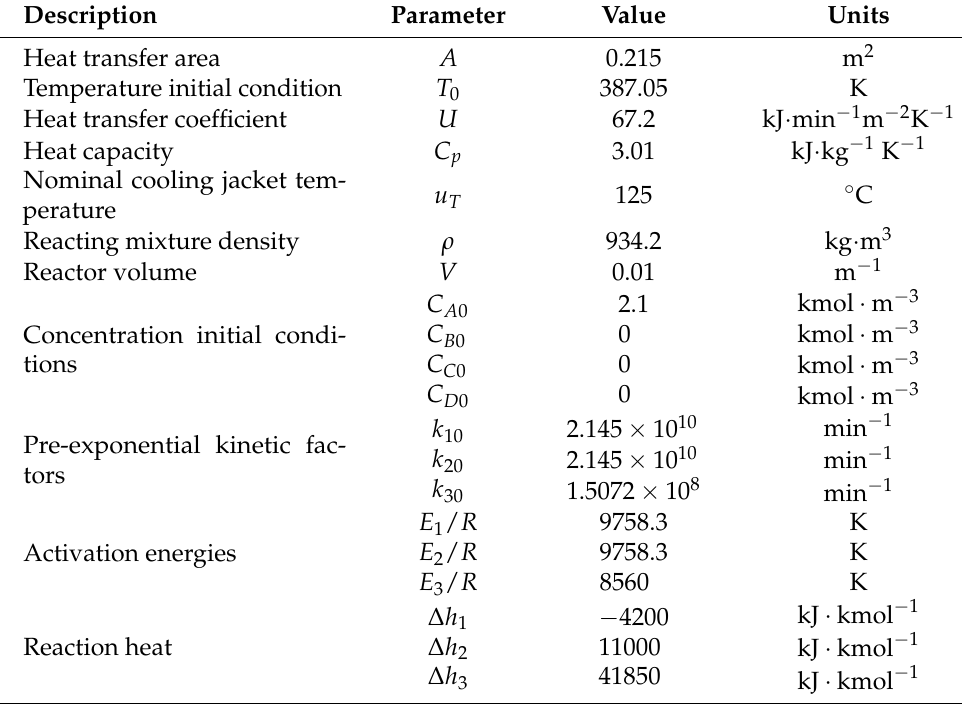
Table 1. Reactor